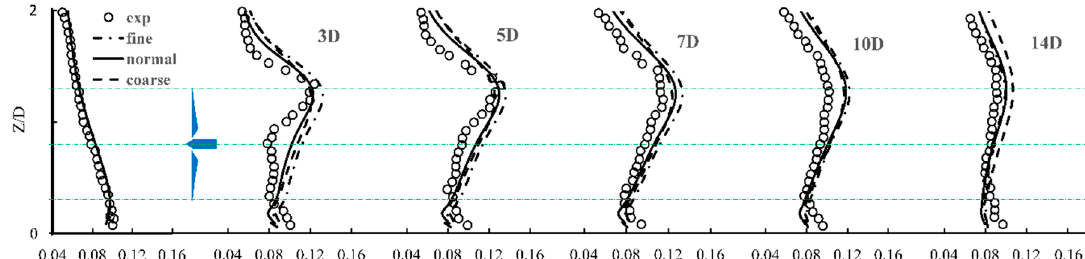
Figure 19. Vertical distribution of stream ‐ wise velocity simulated by different mesh schemes.